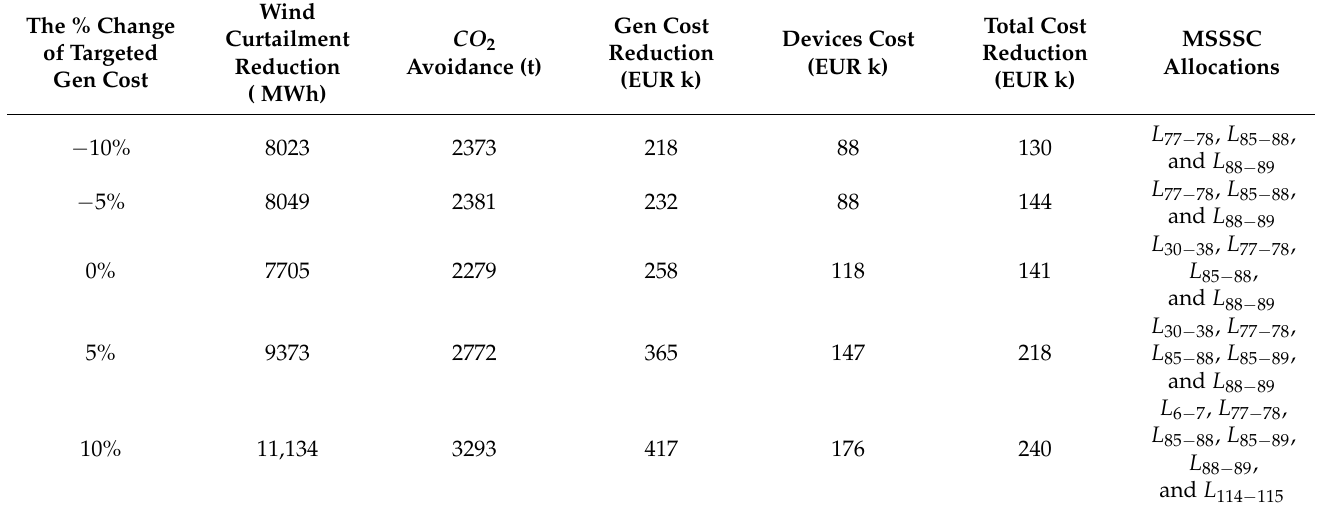
Table 6. Mobile MSSSC allocation sensitivity analysis results.